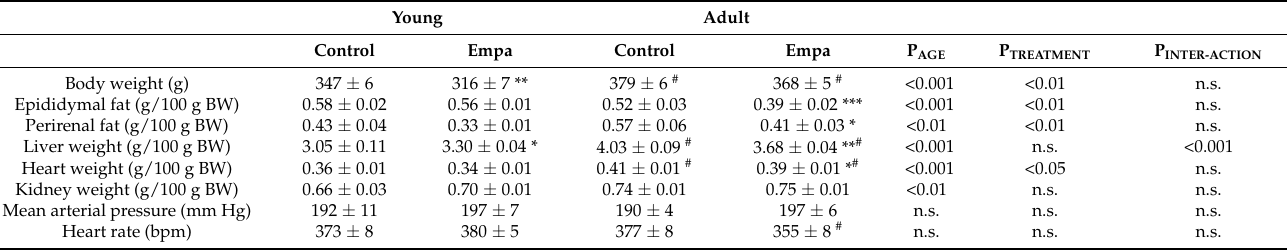
Table 1. Basal parameters in experimental groups during the study.